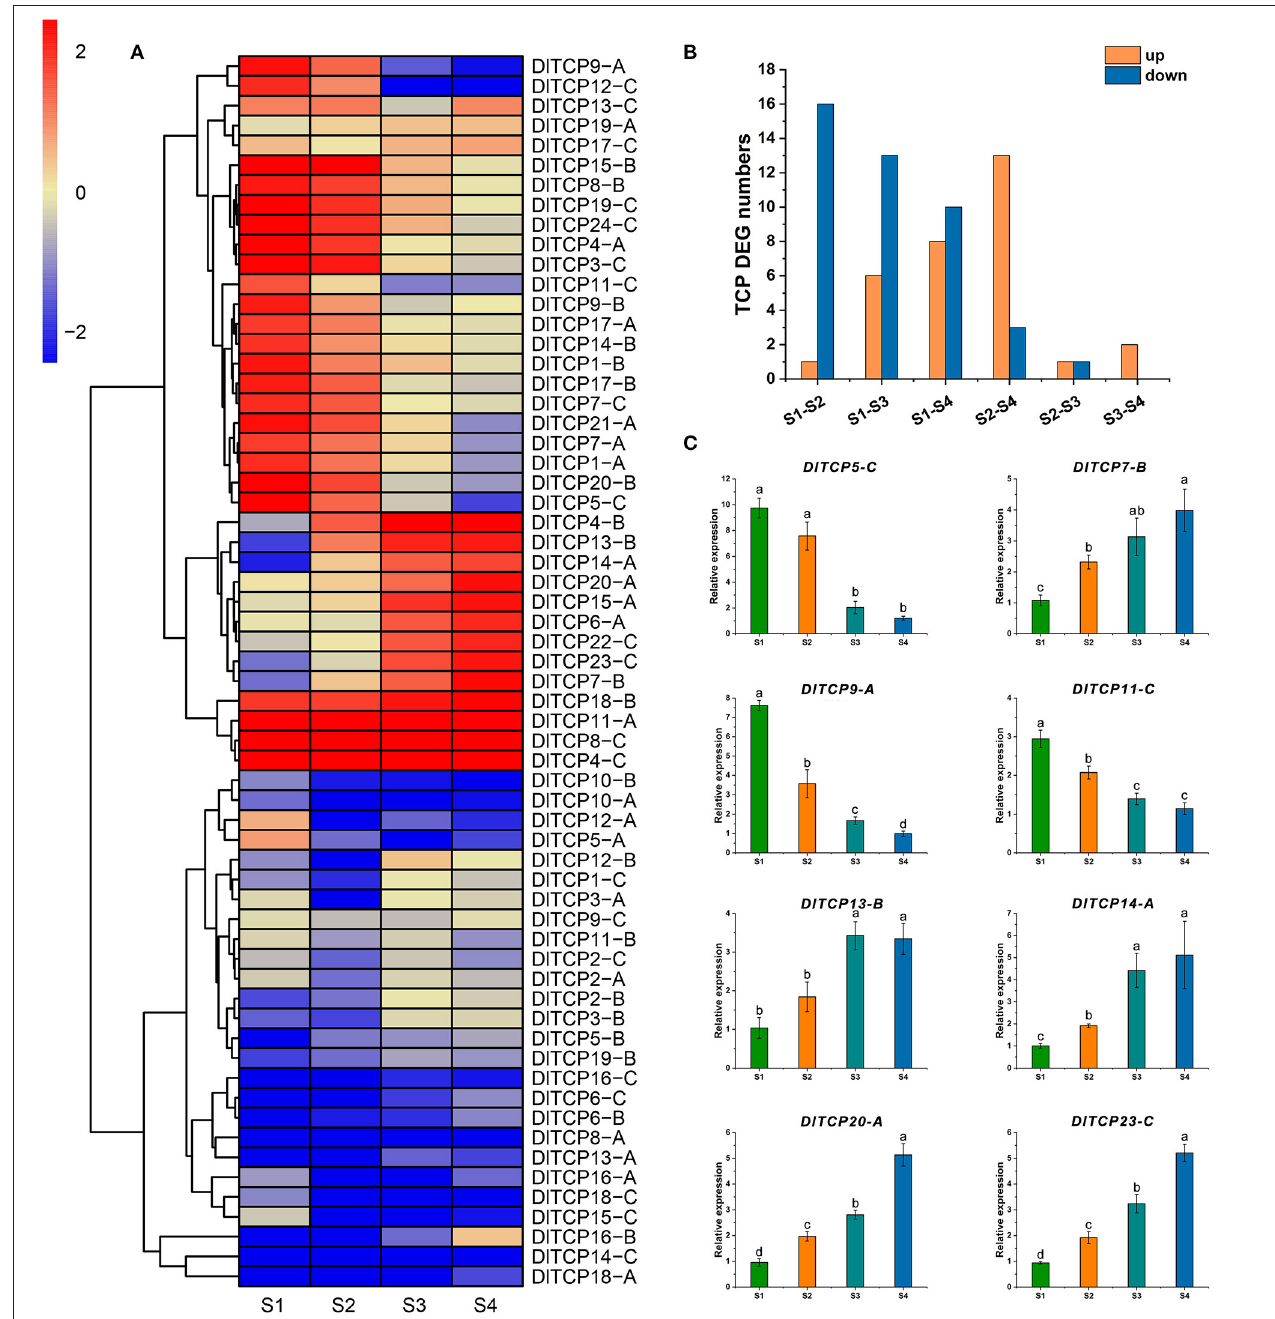
FIGURE 8 | Expression analysis of TCPs in shoot buds at different developmental stages. (A) The expression data of TCP family members in different developmental stages of bamboo shoot buds were retrieved from transcriptome analysis. The results were normalized and visualized by R (4.0.2). (B) The number of TCP differentially expressed genes between different stages. Yellow and blue represent upregulated and downregulated differential expression, respectively. (C) qRT-PCR was used to verify the results of the transcriptome analysis. Error bars were obtained from three replicates. Statistically significant differences between the expression level of different stage were analyzed by Student’s t -test. Those with different marked letters were represented significantly different: p <